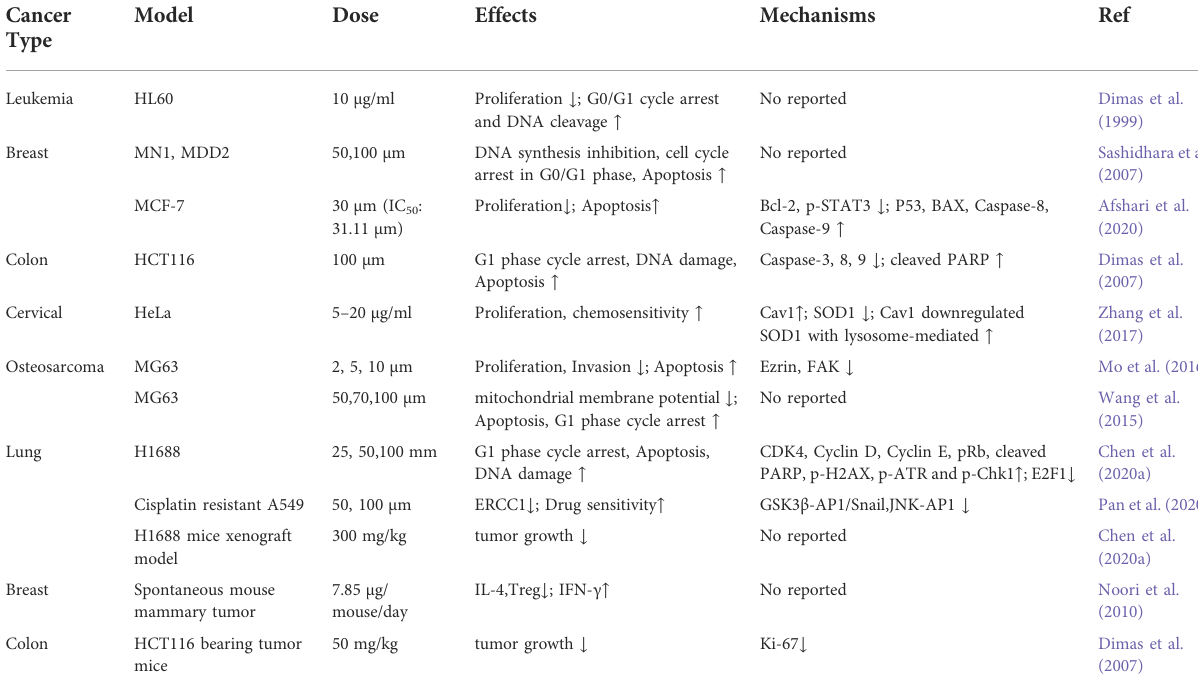
TABLE 1 The effects and mechanisms of SCL against various cancers in vivo and in vitro